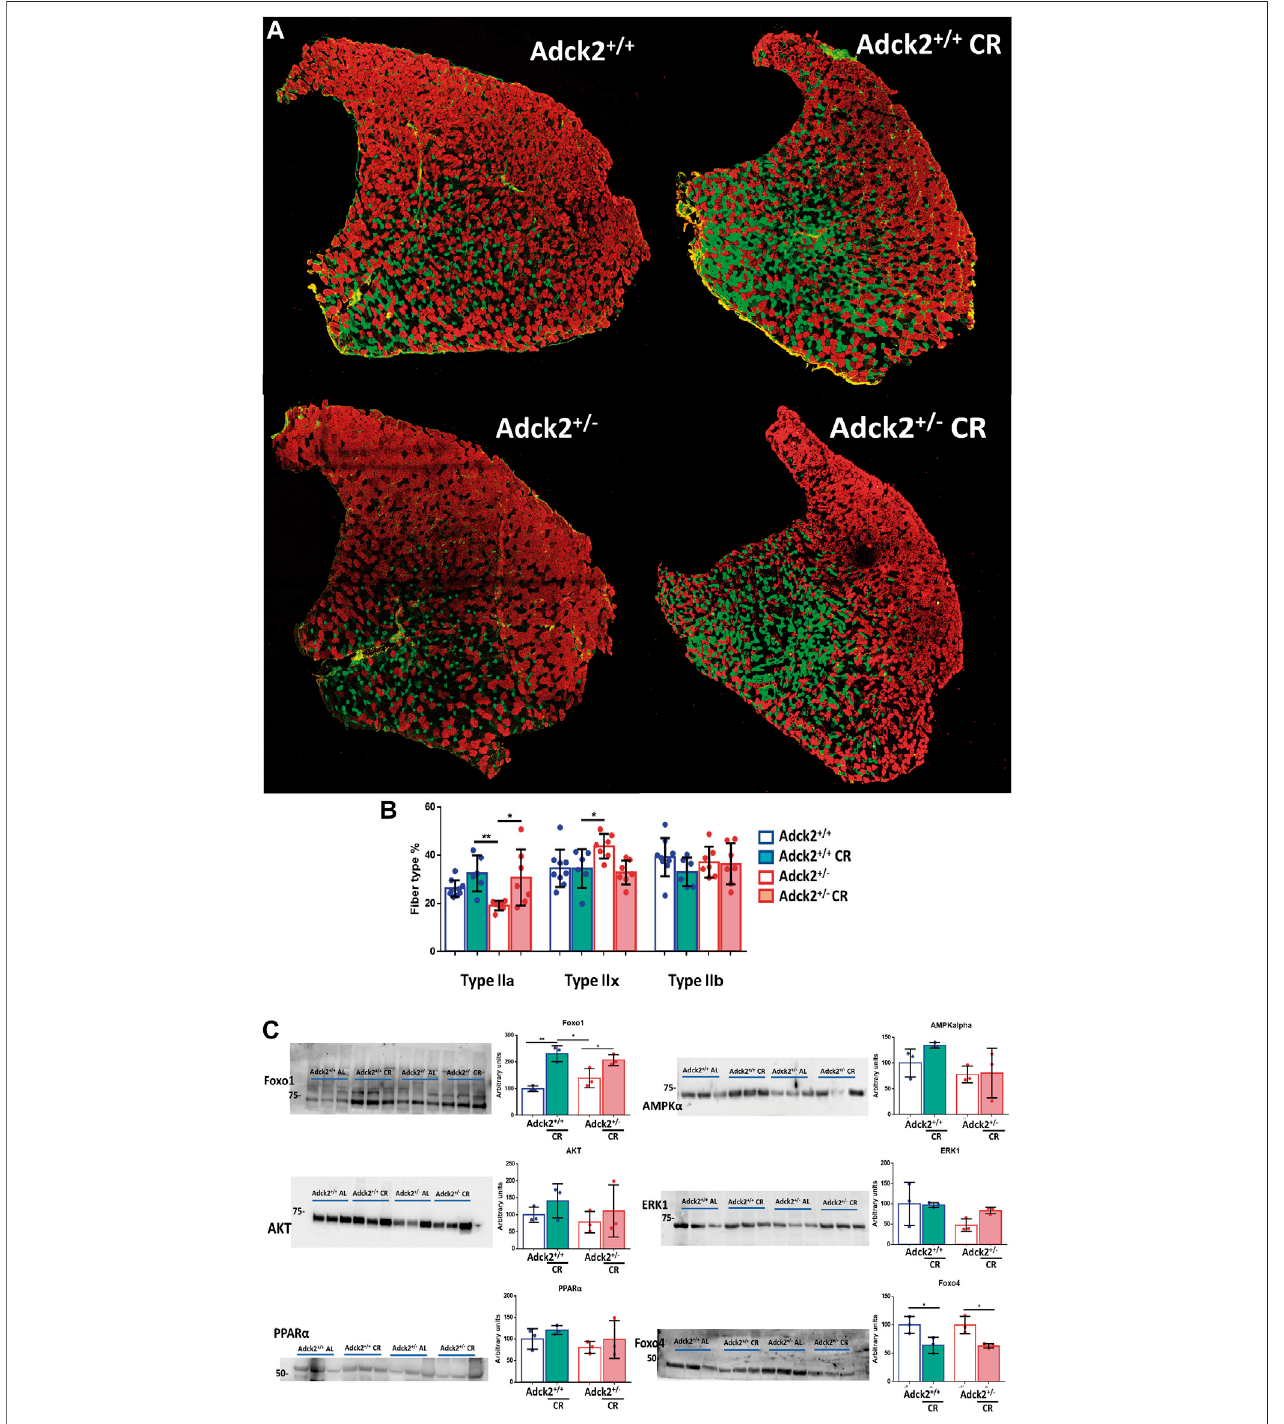
FIGURE4| Myo fi bercompositioninskeletalmuscleundercalorierestrictionconditions. (A) .Representativeimagesoftibialisanterior(TA)musclesfrom13 month- oldmice.TypeIIa,IIb,andIIxmyo fi bersappearingreen,redandblack,respectively. (B) .Myo fi ber compositionanalysis.Datarepresent themean±SD(Adck2 +/+ N=9, Adck2 +/ − N = 7, Adck2 +/+ CR N = 6, Adck2 +/ − CR N = 7) (C) . Protein levels of metabolic markers performed in protein homogenates from gastrocnemius muscles. CR, calorie restriction. Data represents the mean ± SD (N = 3). Unpaired two-tailed t -test and one-way ANOVA test were applied. * p < 0.05; ** p < 0.01; *** p < 0.001; **** p < 0.0001.